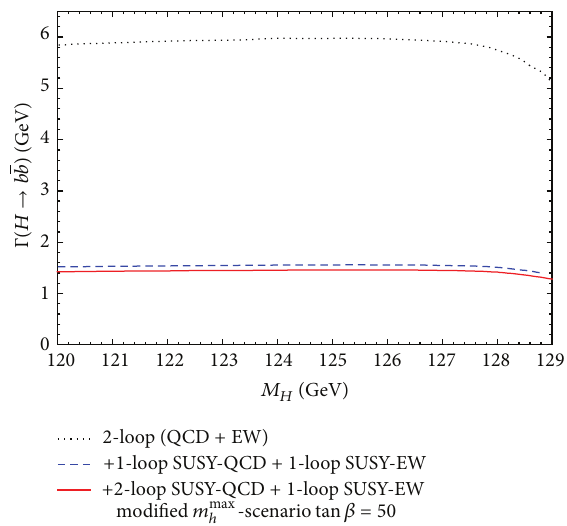
Figure 19: Γ(ℎ → 𝑏𝑏) for the “modified 𝑚 max ℎ ” scenario as a function of 𝑀 ℎ . The dotted line displays the two-loop QCD and electroweak corrections together with two-loop corrections to the Higgs boson propagator. The dashed and solid lines depict in addition the one- and two-loop SUSY-QCD vertex corrections,